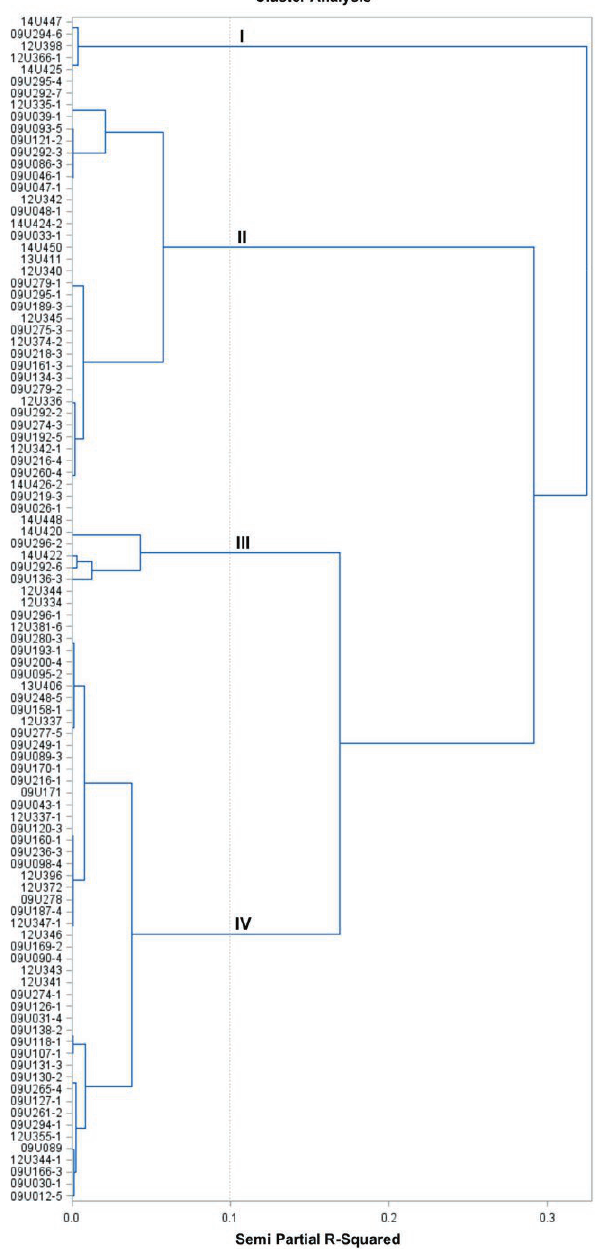
Figure 3. Dendrogram of grouping by number of chloroplasts in stomatal cells and chromosome number of 100 genotypes of P. peruviana